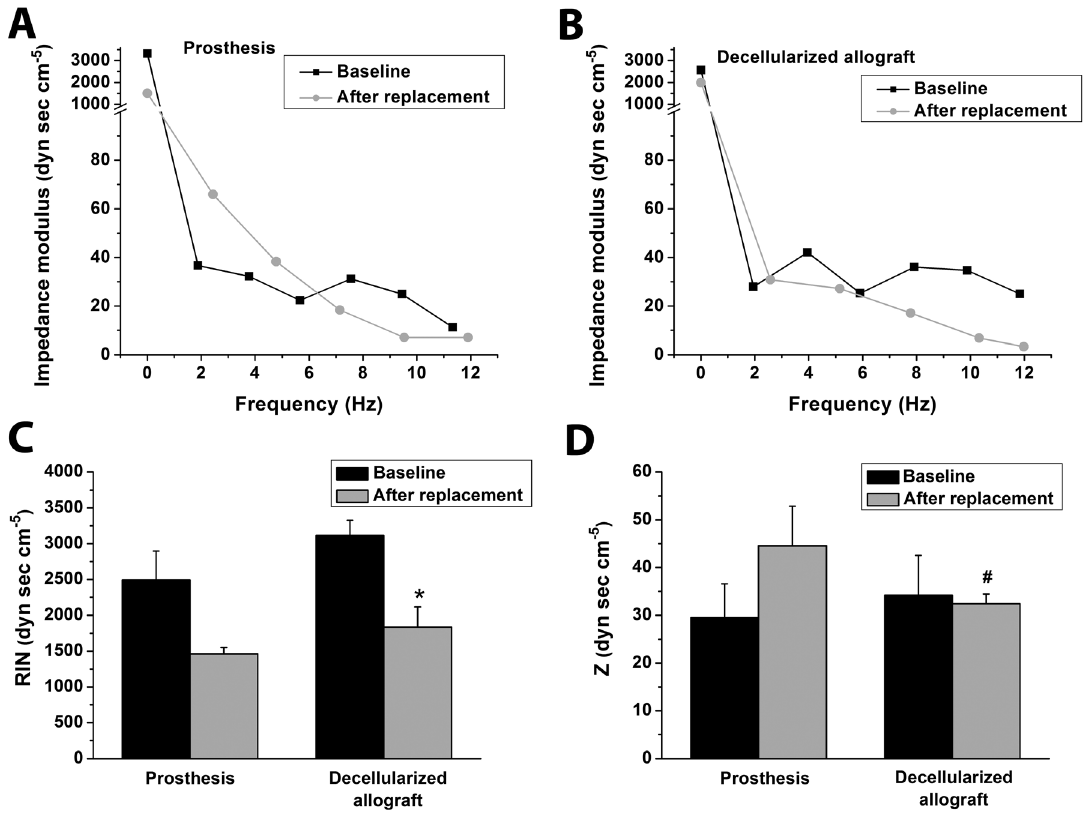
Figure 6. Vascular impedance spectrum . Vascular impedance spectrum after total aortic arch replacement in a representative animal of the prosthesis (A) and decellularized allograft group (B). Input impedance (RIN, C), and characteristic impedance (Z, D) at baseline and after total aortic arch replacement in both groups. All values on panels C and D are given as means 6 SEM, *:P , 0.05 vs. Baseline, # :P , 0.05 vs. Prosthesis